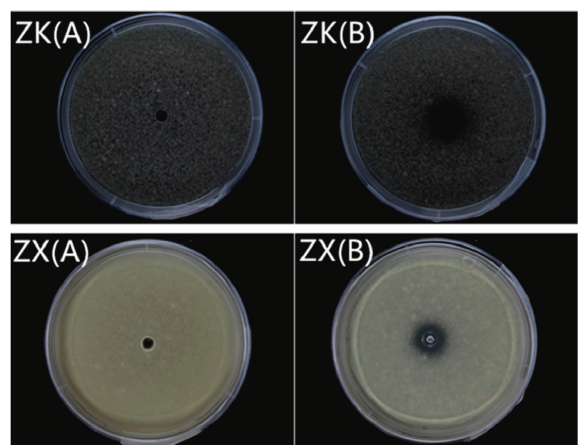
Figure 6: The sensitivity of citral on ZK and ZX. A: control (untreated); B: the experimental group (150mg L − 1 Table 3: The toxicity equation of citral on ZK and ZX.